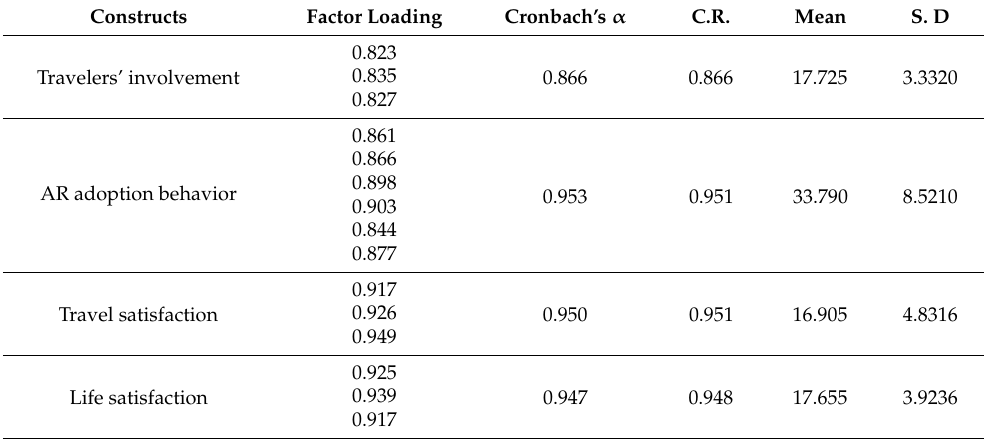
Table 2. Table 2. Validity and reliability of